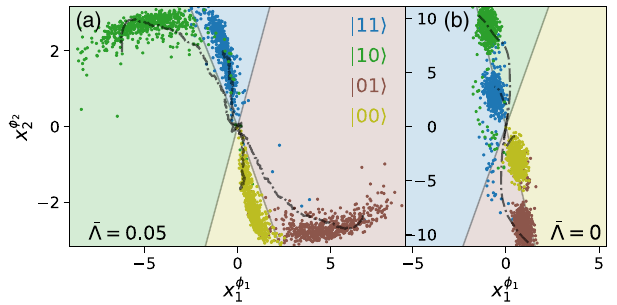
FIG. 6. (a) Classification dynamics in the measured subspace ¯ Λ for a K ¼ 2 RC with parameters γ ¼ 0 . 2 , α ¼ 1 . 9 , ¼ 5 × 10 − 2 , and μ ¼ 5 . In (b) we show the same network but with Λ ¼ 0 . Regions in RC phase space are colored according to their learned classification output; e.g., the region in ð x ϕ 1 1 ; x ϕ 2 2 Þ space for which P 11 is largest is filled in blue. The separating lines constructed ˜ W are also shown. Dots indicate the final RC from the trained o state generated by each signal in the test set, which are colored according to their ground truth j ψ ð 0 Þi ¼ j z i . Therefore, when the colors of the dots and the underlying region are the same, the classification result is